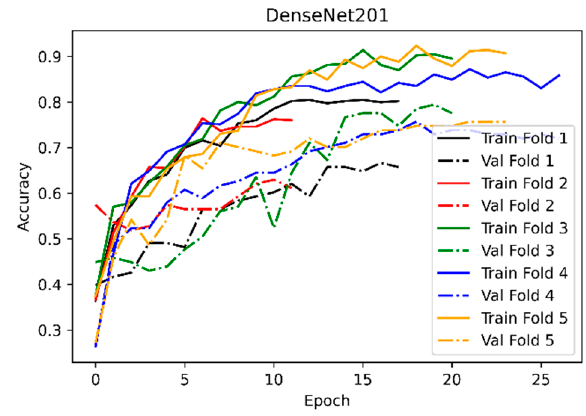
Figure 4. The learning curve of the DenseNet201 network.